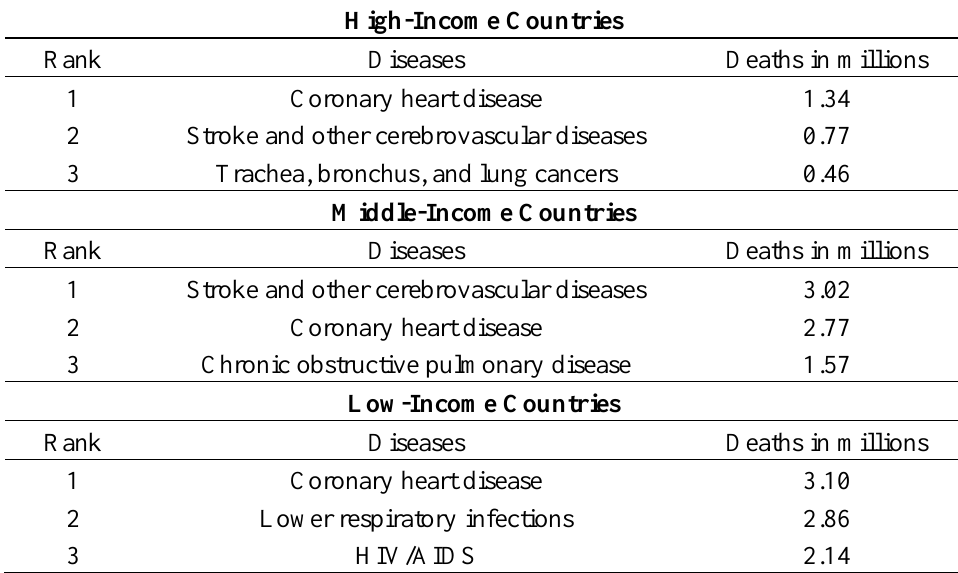
Table 1. Top-3 causes of death in high-, middle-, and low-income